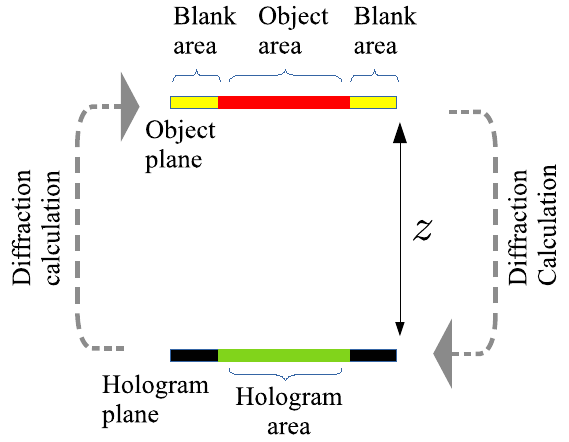
Figure 1. Conventional